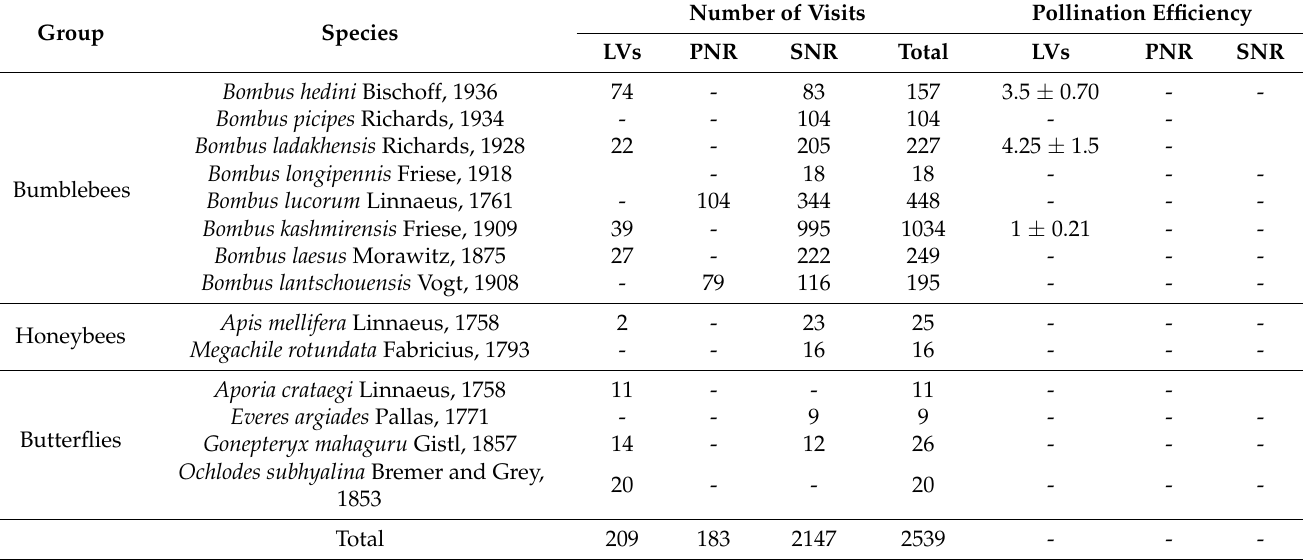
Table 1. Number of legitimate visits (LVs) and illegitimate visits (IVs: PNR = primary nectar robbing; SNR = secondary nectar robbing) per visitor on S. officinale and pollination efficiency. Number of Visits Pollination Efficiency Group Species